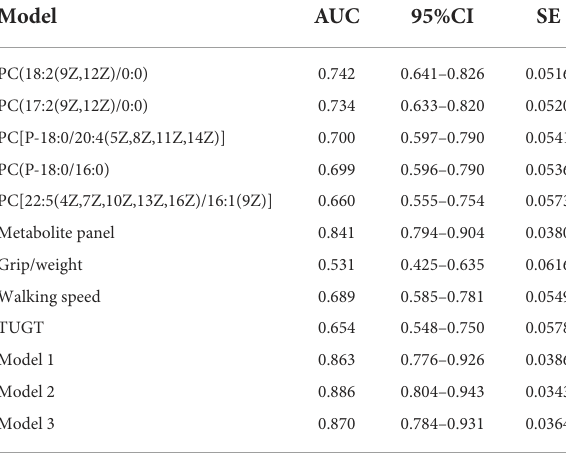
Model1:Grip/weight,plusmetabolitepanel. Model2:Walkingspeed,plusmetabolitepanel.